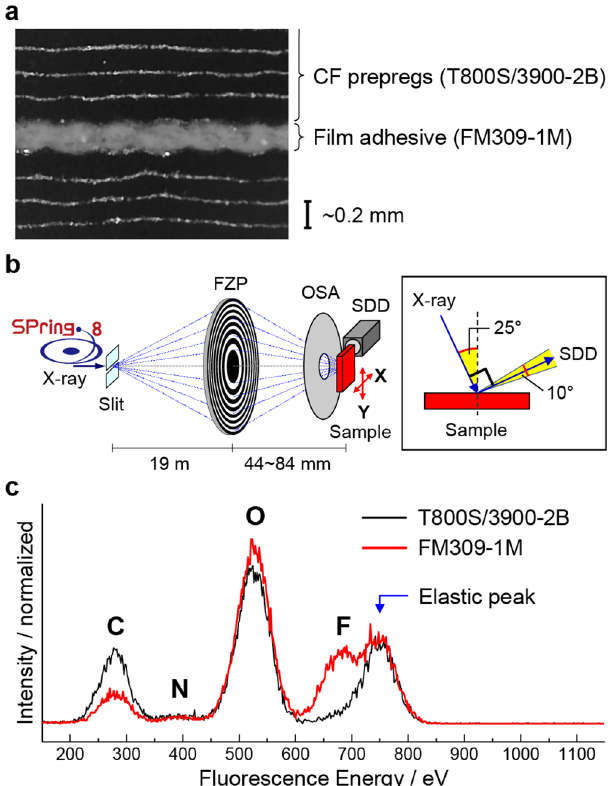
Figure 1. Sample structure, experimental setup, and elemental composition of materials. ( a ) An optical microscope image of the cross-section in the CF prepreg (T800S/3900-2B) joining structure adhered by the adhesive film (FM309-1 M). ( b ) Schematics of the X-ray focusing optics and the measurement geometry of SXM. A soft X-ray beam was focused on using FZP and OSA. μ -XRF spectra were measured using SDD with an acceptance angle of 10°. ( c ) μ -XRF spectra ( hv = 750 eV) in the CF region of T800S/3900-2B and the resin region in FM309-1 M. The SXM image was obtained by measuring μ -XRF while scanning the sample in the X and Y